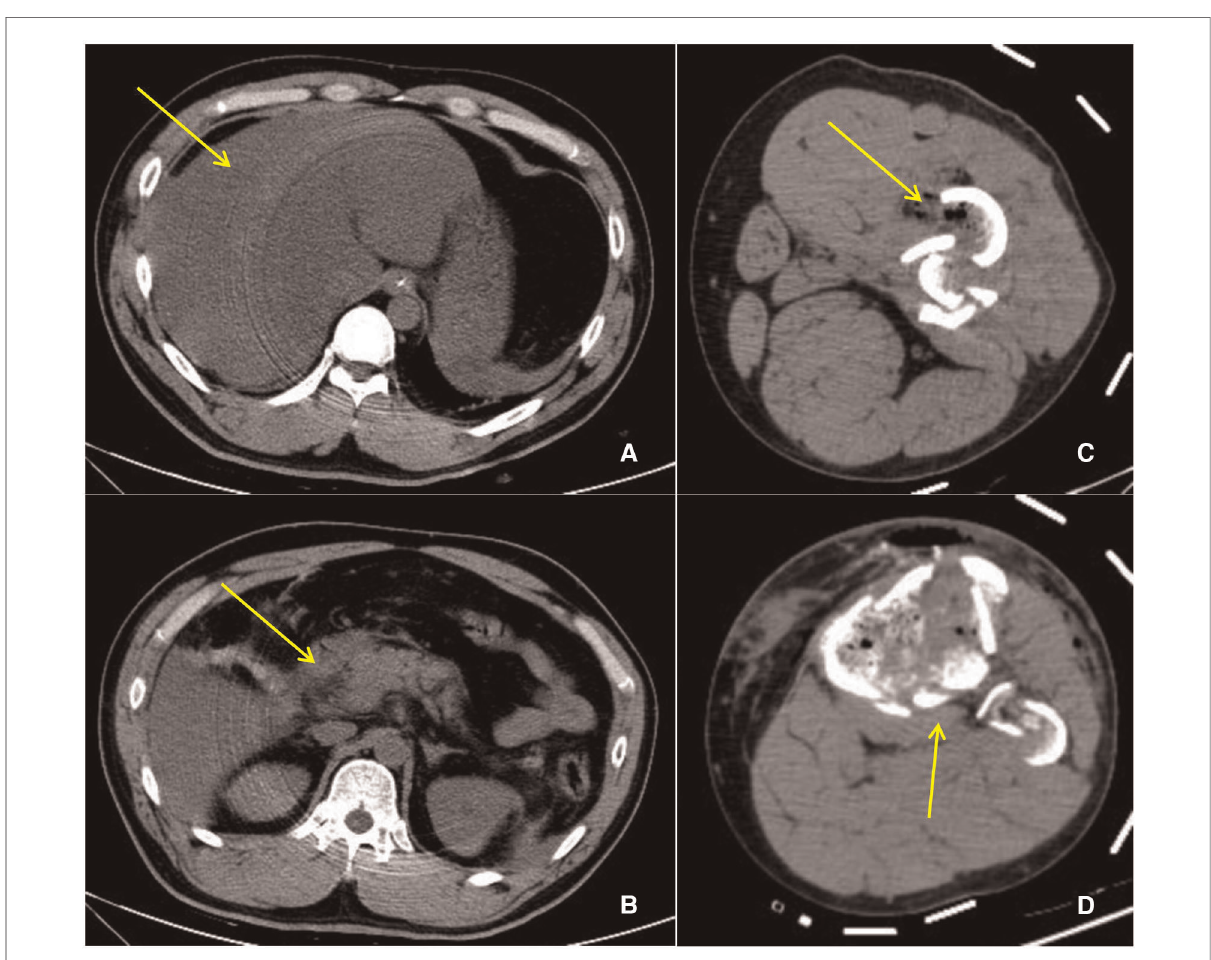
FIGURE 1 CT manifestation post polytrauma. ( A ) Liver rupture, perihepatic hemorrhage (yellow arrow). ( B ) Exudation around the pancreatic head. ( C ) Fracture of the left femoral backbone. ( D ) Fracture of the left